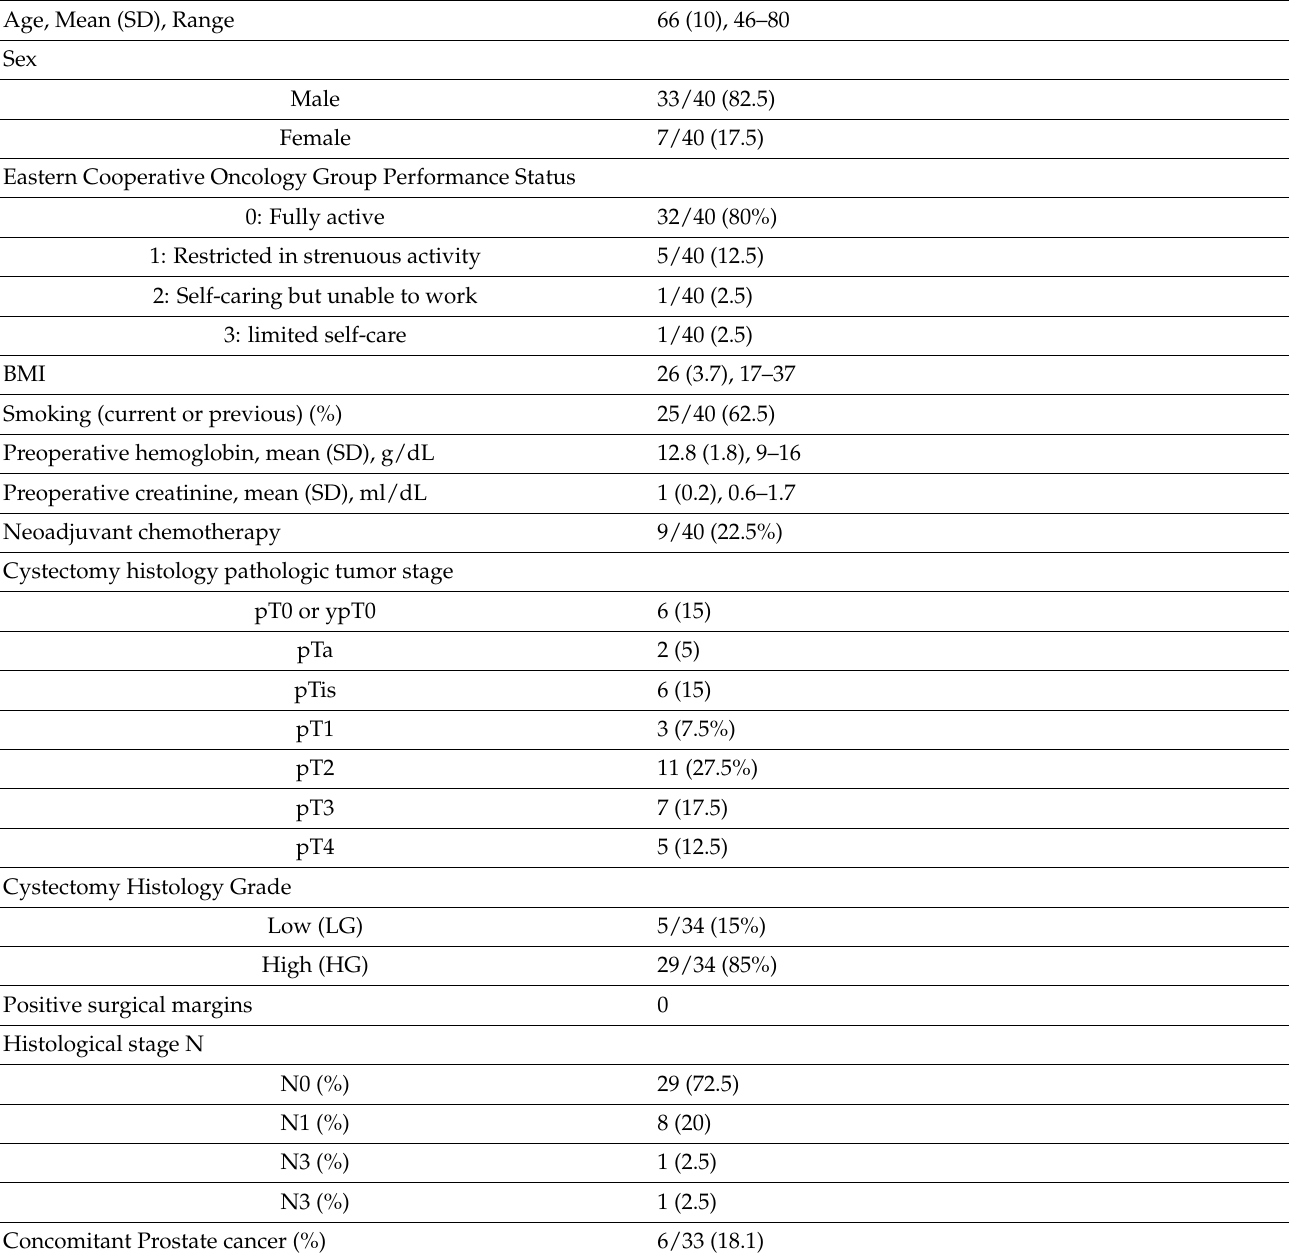
Table 1. Demographic, pre-operative, and final pathological